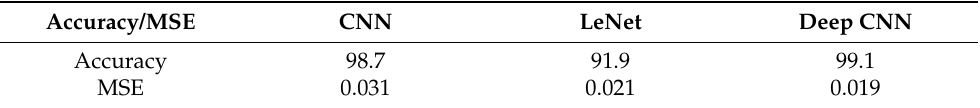
Table 4. Accuracy and Loss Comparison of CNN, LeNet, and Deep CNN Models on the Pashto Character Dataset.